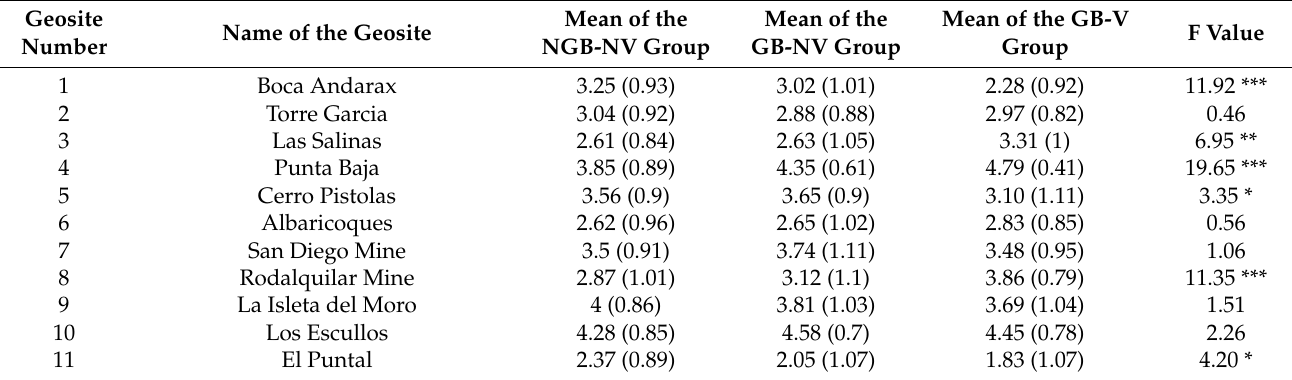
Table A4. Comparison of mean scenic beauty ratings (standard deviations in parentheses) of the 34 individual geosites by the three groups of respondents, grouped following their geoscience background and field visits: NGB-NV = No- Geoscience Background-No Visit to geosites; GB-NV = Geoscience Background-No Visit to geosites; GB-V = Geoscience Background-Visit to